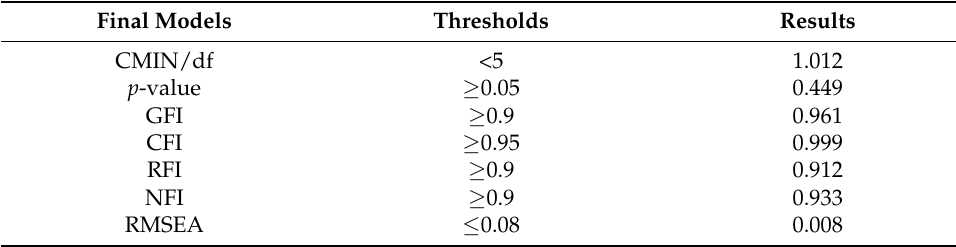
Table 2. Model fits for the study constructs.